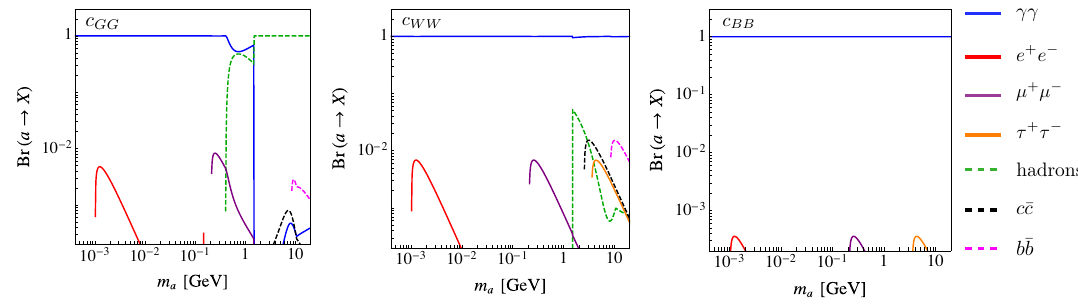
Figure 17 . Branching ratio for an ALP with couplings to either c GG (left), c WW (central) and c BB (right) at Λ = 4 πf and f = 1 TeV. The branching ratios of the ALP into photons and charged leptons are indicated by solid lines and the branching ratios of the ALP into hadronic states are given by dashed